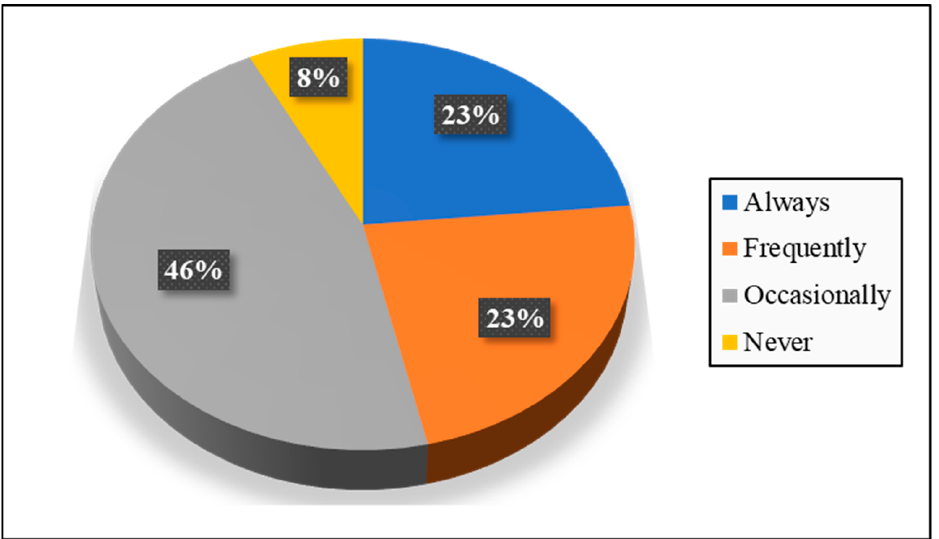
Figure 4. Percentage of SFFES use frequency based on four categories.